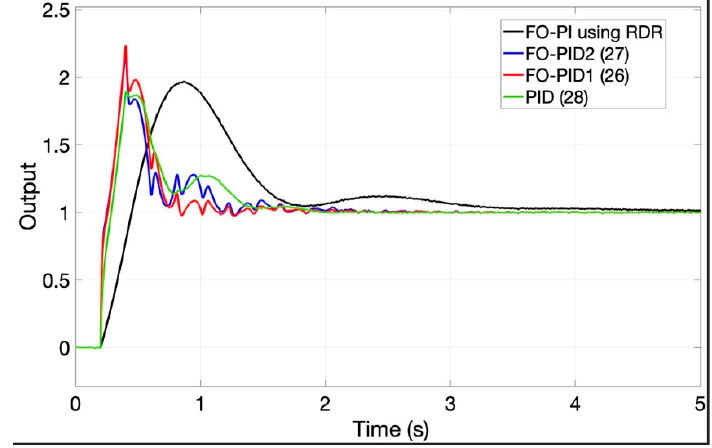
Figure 25. Reference tracking results for an unstable time delay process.